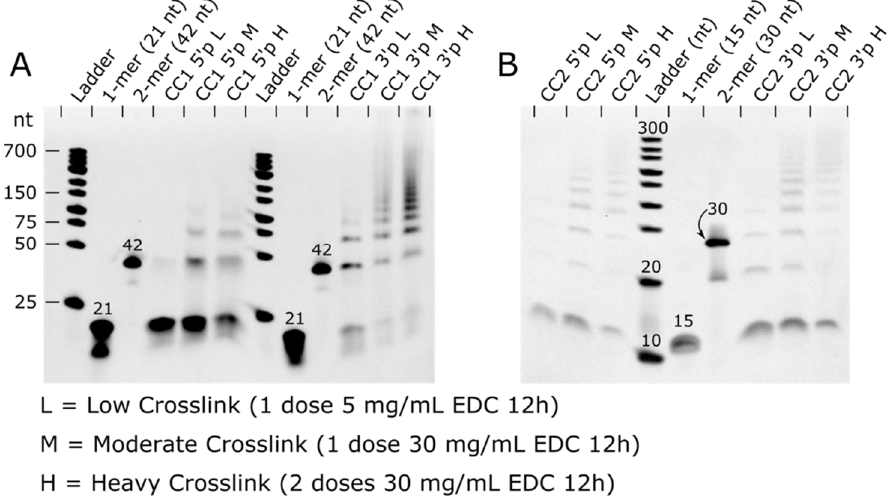
Figure 4. TBE-urea gels of: ( A ) CC1; and ( B ) CC2 chemical ligation. In both co-crystals, additional ligation was achieved with increased EDC concentration and a second EDC dose. ( A ) A 10% TBE-urea gel of CC1 illustrating a much-improved ligation product distribution for 3 ′ vs. 5 ′ phosphates. ( B ) A 15% TBE-urea gel of CC2 illustrating a modestly improved ligation product distribution for 3 ′ vs. 5 ′ phosphates. Assigned band sizes are given in nt.